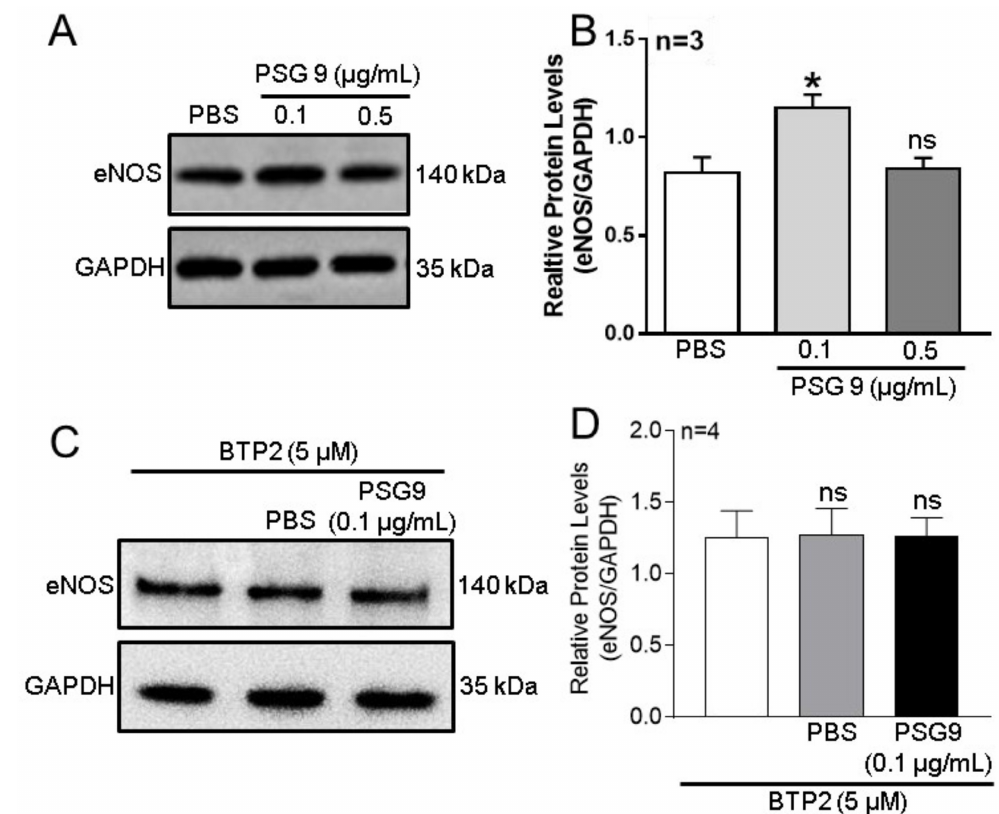
Figure 4. Effect of PSG9 on endothelial nitric oxide synthase (eNOS) expression level in hu- man umbilical vein endothelial cells (HUVECs). ( A – D ) Representative Western blot images ( A , C ) and summary data ( B , D ) showing the expression of eNOS in HUVECs incubated with PBS or different concentrations (0.1 or 0.5 µ g/mL) of PSG9 for 24 h ( A , B ), or with BTP2 (5 µ M) + PBS or BTP2 (5 µ M) + PSG9 (0.1 µ g/mL) ( C , D ). Values are shown as the mean ± SEM. * p < 0.05 compared with PBS; ns, no significant